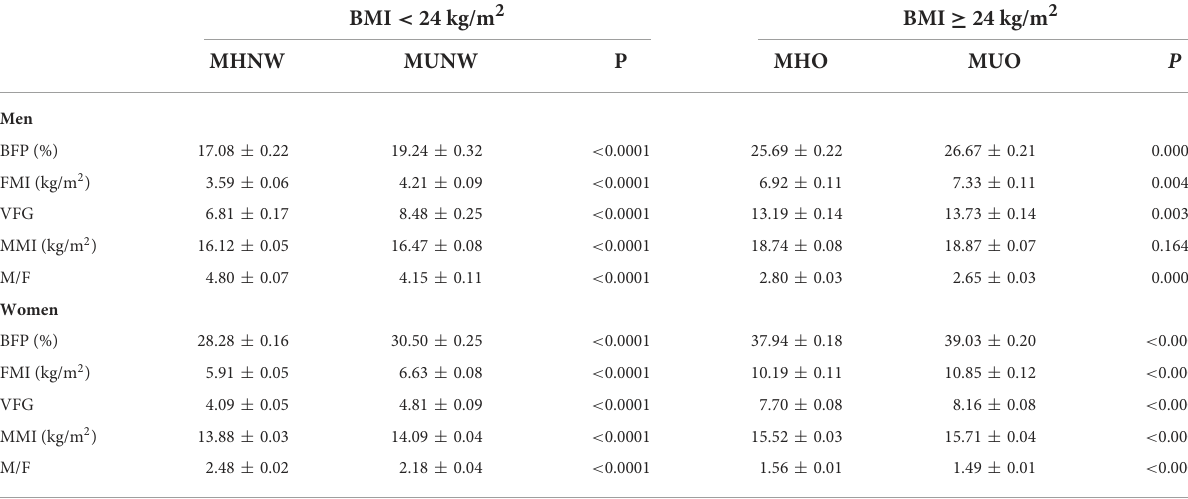
TABLE 2 Covariance analysis of body composition between metabolically healthy and unhealthy participants by sex and